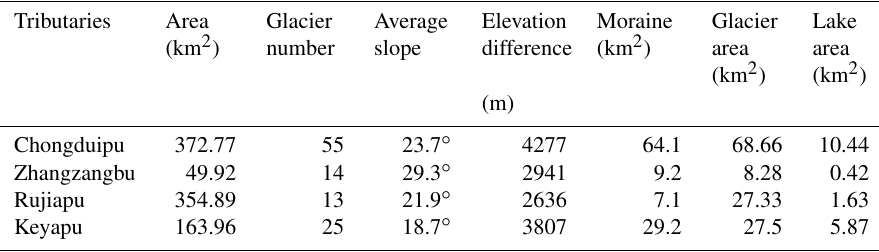
Table 6. Parameters of the four glacial lake